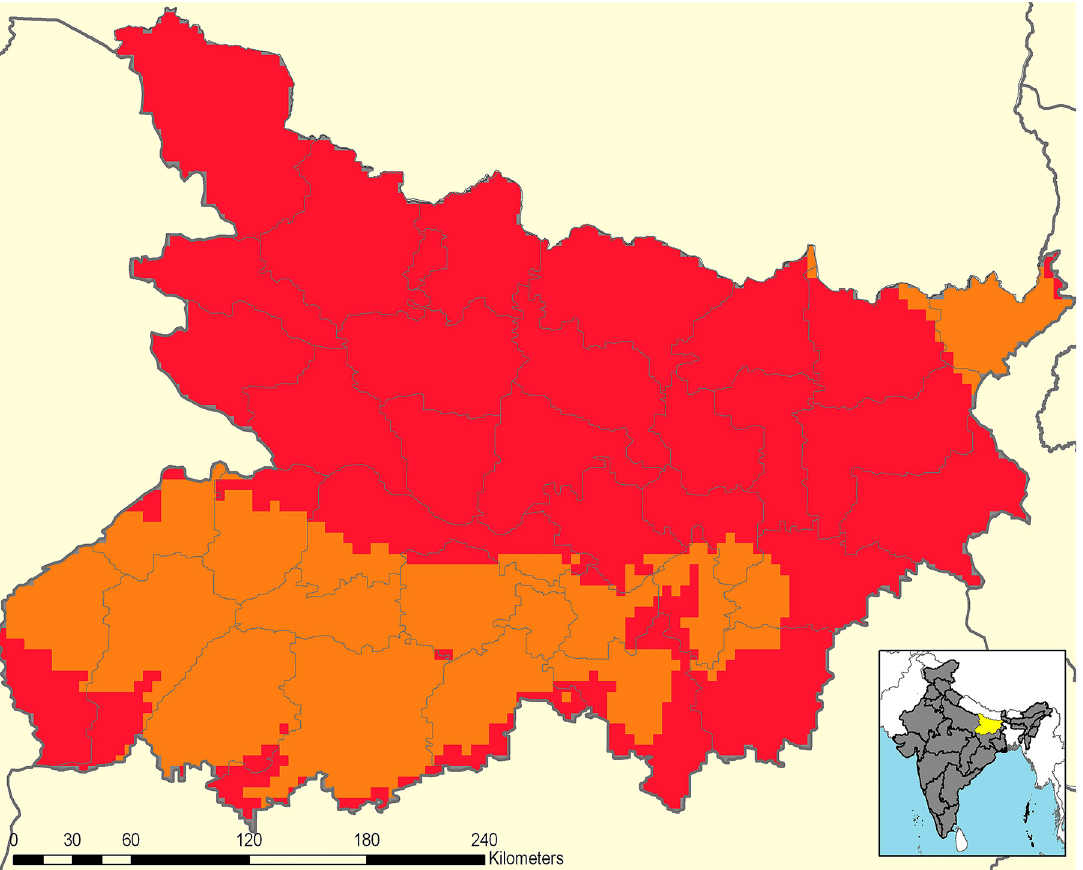
Fig 2. Predictive prevalence map of soil-transmitted helminths in Bihar state. Predictive mapping was used to inform the state wide deworming coverage in Bihar. The map shows areas of high prevalence ( (cid:1) 50% infection) in red, and moderate prevalence ( (cid:1) 20% and < 50% infection) in orange. The map presented was developed by Jenny Smith as part of the Global Atlas of Helminth Infections project